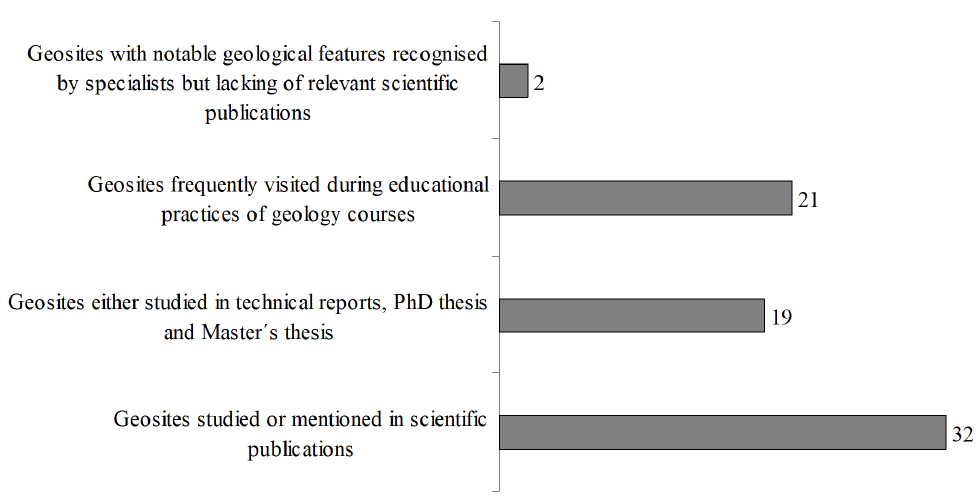
Figure 5 - Frequency of geosites mentioned in each category. The same geosite can be cited in more than one category.